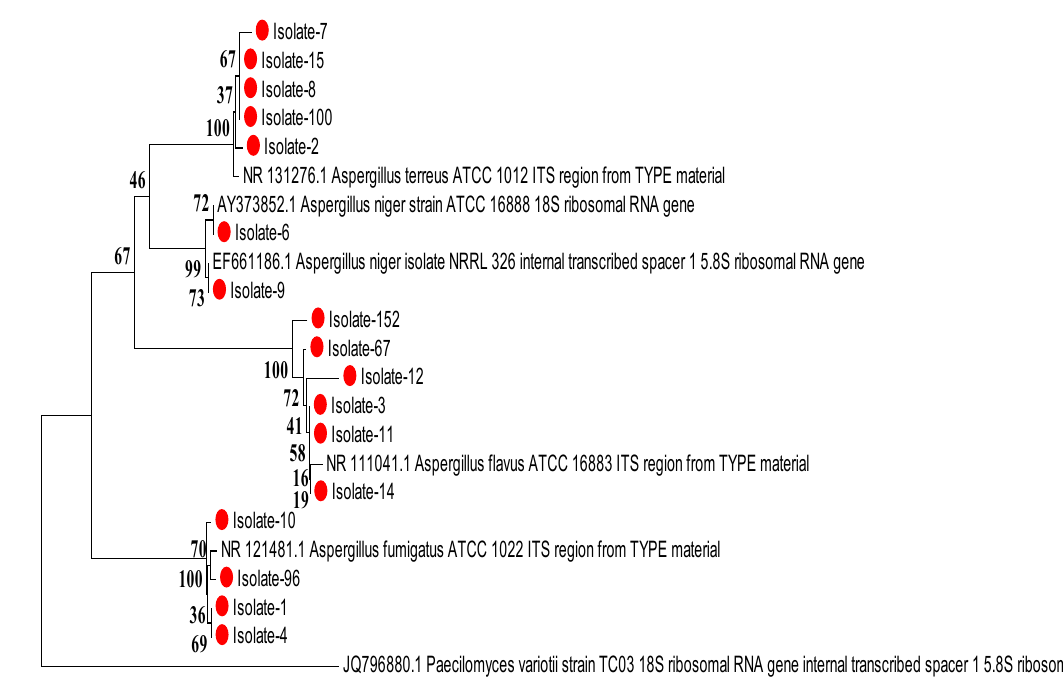
Figure 3. Phylogenetic tree based on interspaced gene sequences of 17 isolates (marked in red circles) from pulmonary aspergillosis patients. The phylogenetic tree analysis was constructed using the neighbor-joining method in MEGA 7. Paecilomyces variotii is used as the out-group to root the tree.